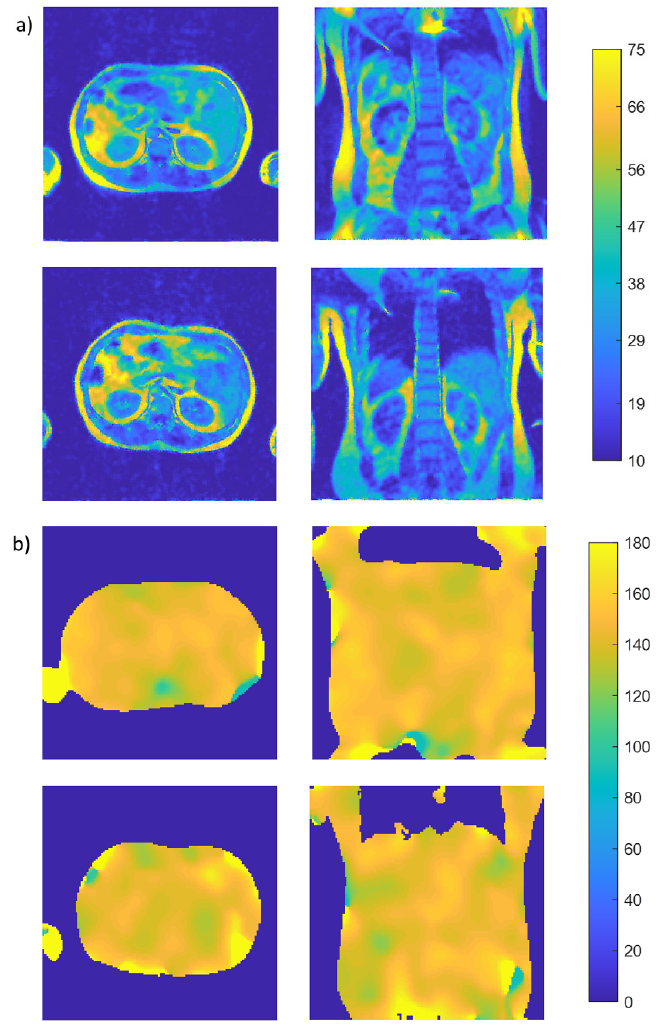
Figure 5. Experimental MRI results of in vivo human volunteer obtained in axial and coronal orientations: ( a ) SNR map acquired using T1w spin echo sequence; ( b ) FA map (nominal FA— 180 ◦ ) acquired using composite spin echo sequence in commercial circular birdcage (top row) and constructed split-type elliptical birdcage (bottom